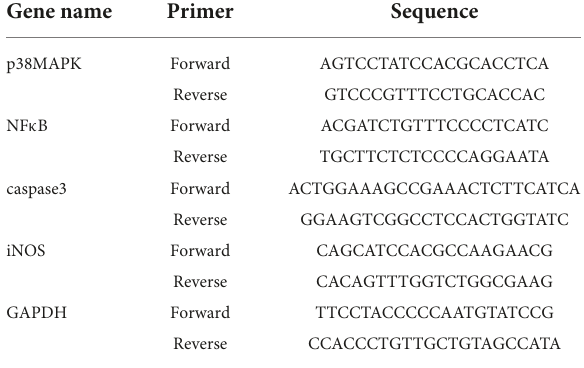
TABLE 1 The primers used in